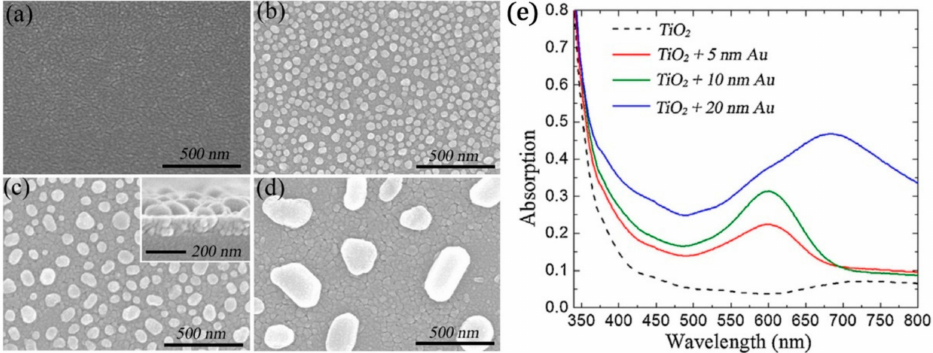
Figure 9. SEM images of ( a ) as-grown 10-nm-thick Au film sputtered on 100-nm-thick TiO 2 layer and 400 ◦ C annealed composite structures with di ff erent initial Au film thickness of ( b ) 5 nm, ( c ) 10 nm, ( d ) 20 nm and ( e ) UV–vis absorption spectra for the prepared TiO 2 films without and with Au nanoparticles on the surface of TiO 2 . The inset in (c) shows the cross-section SEM image of the Au NPs–TiO 2 composite structure. Adapted with permission from [43]. Copyright (2014)